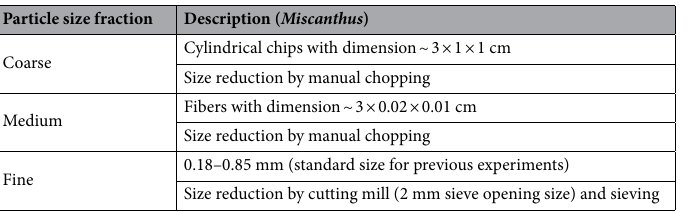
Table 2. Particle size fractions for pretreatment of Miscanthus × giganteus after comminution by hammer milling 63–65 .